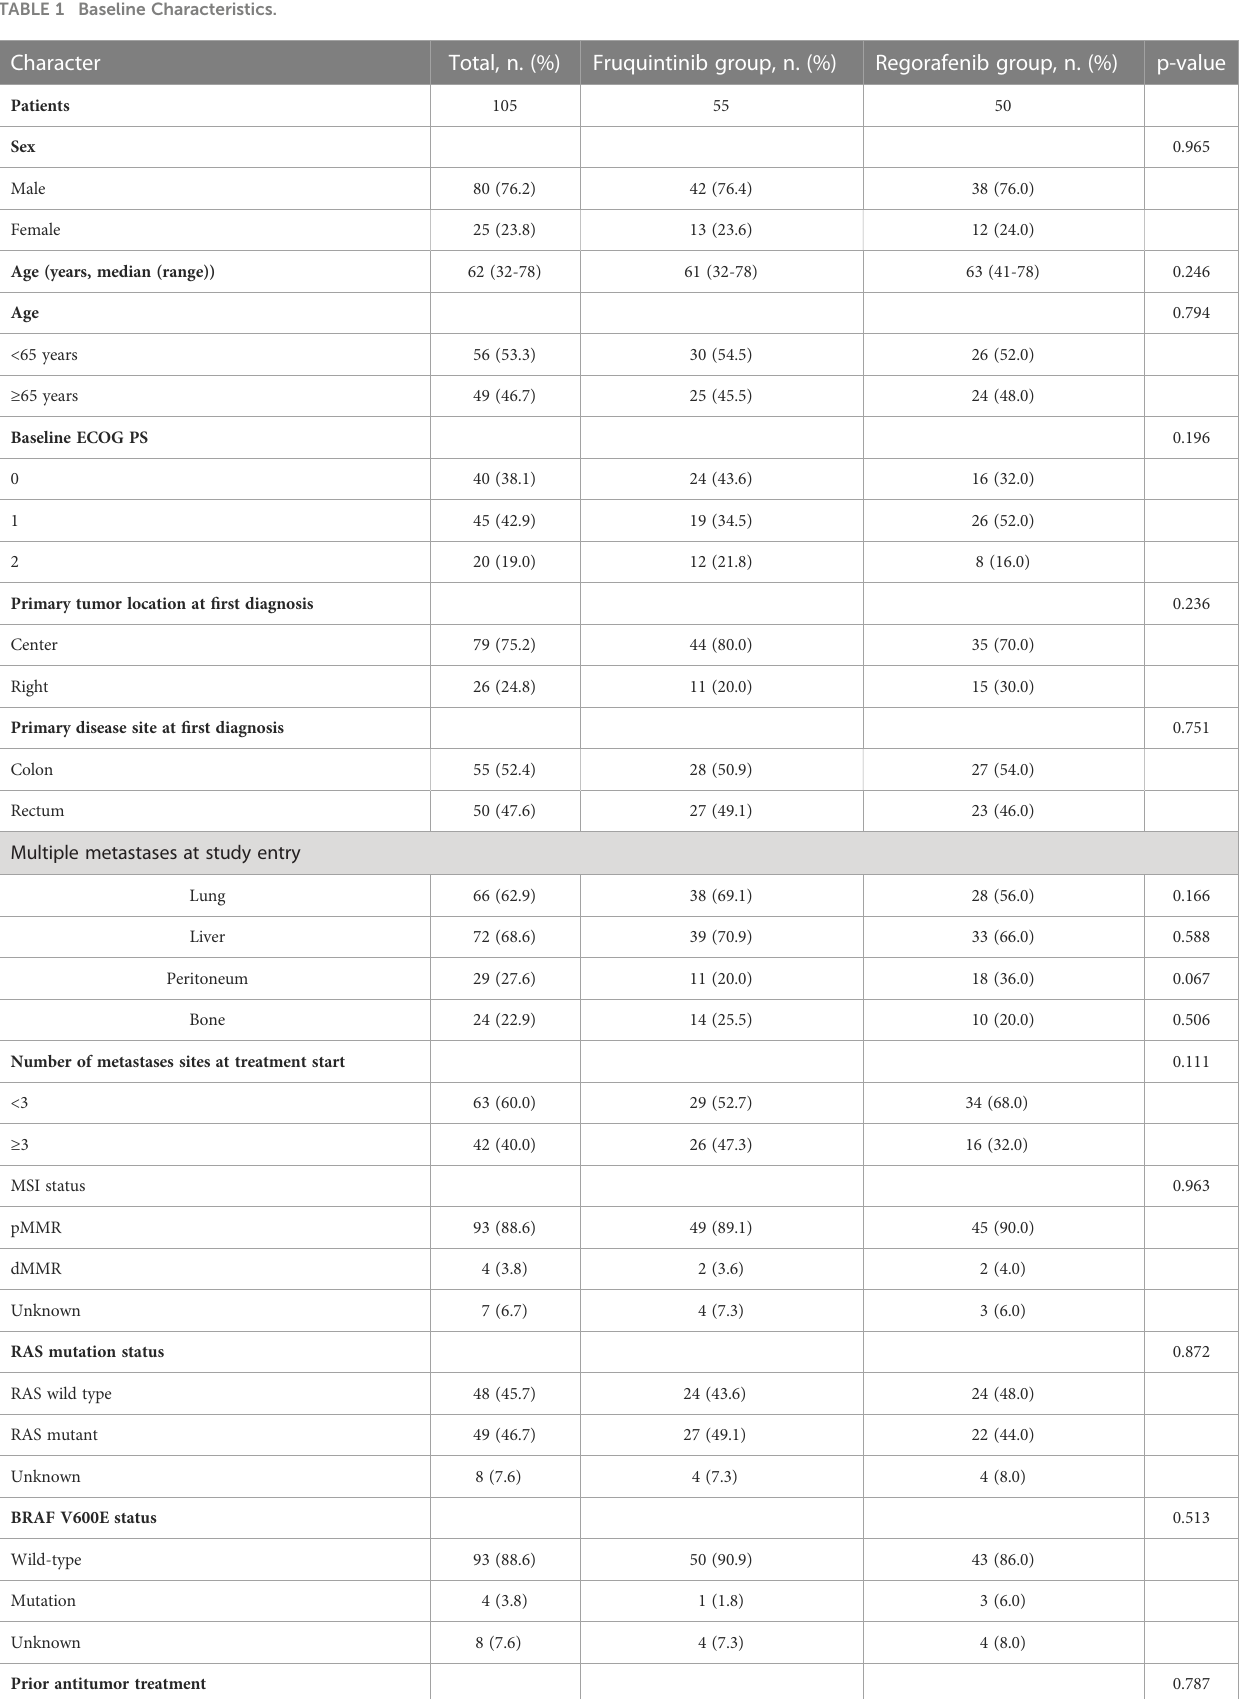
TABLE 1 Baseline